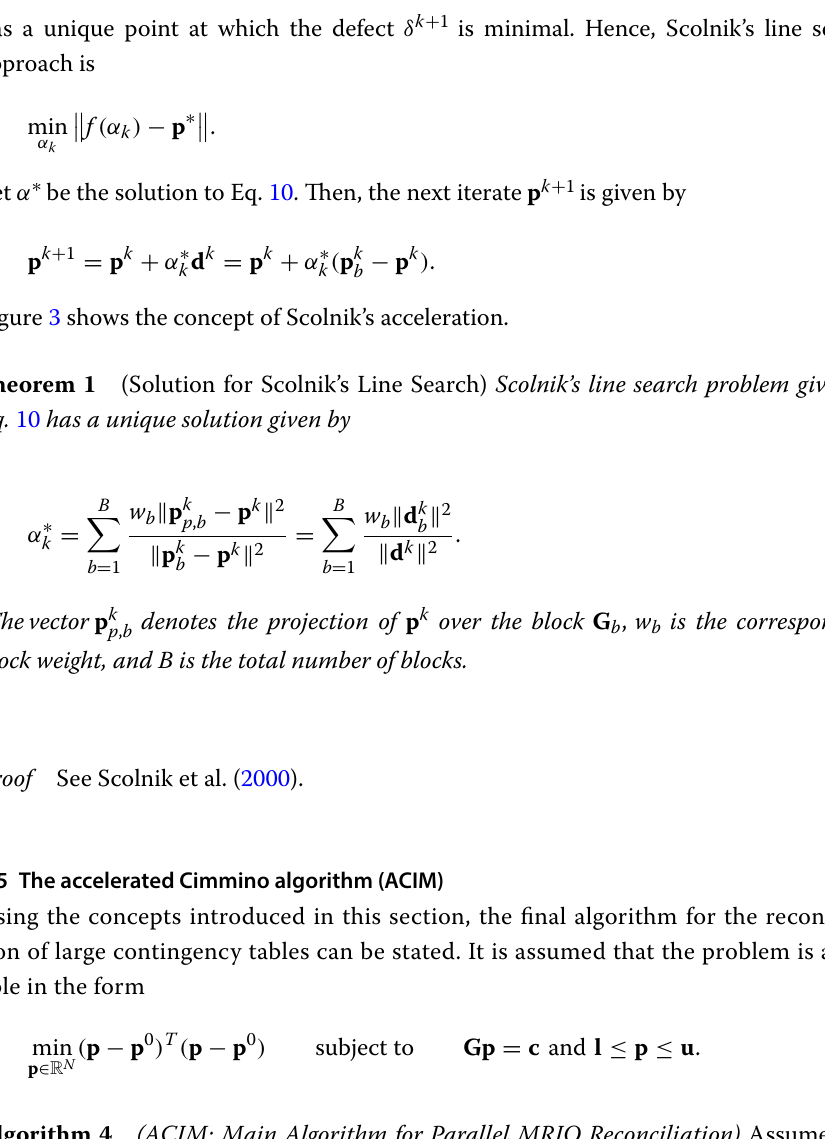
Algorithm 4 (ACIM: Main Algorithm for Parallel MRIO Reconciliation) Assume that � g m � = 1 for all m = 1, . . . , M